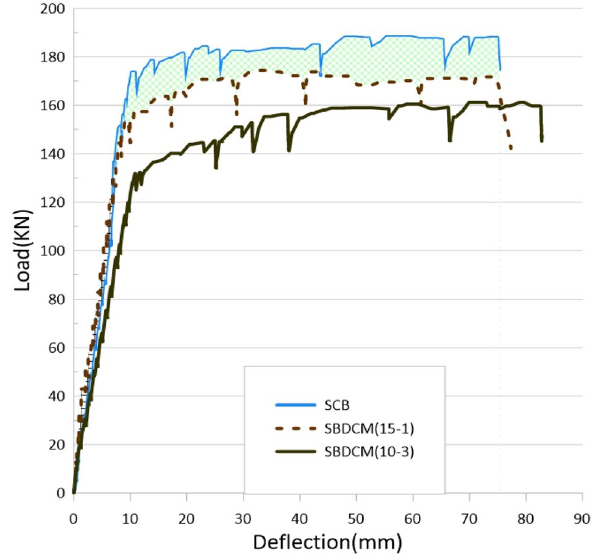
Fig. 9 Load–deflection of specimens with different damage widths and heights